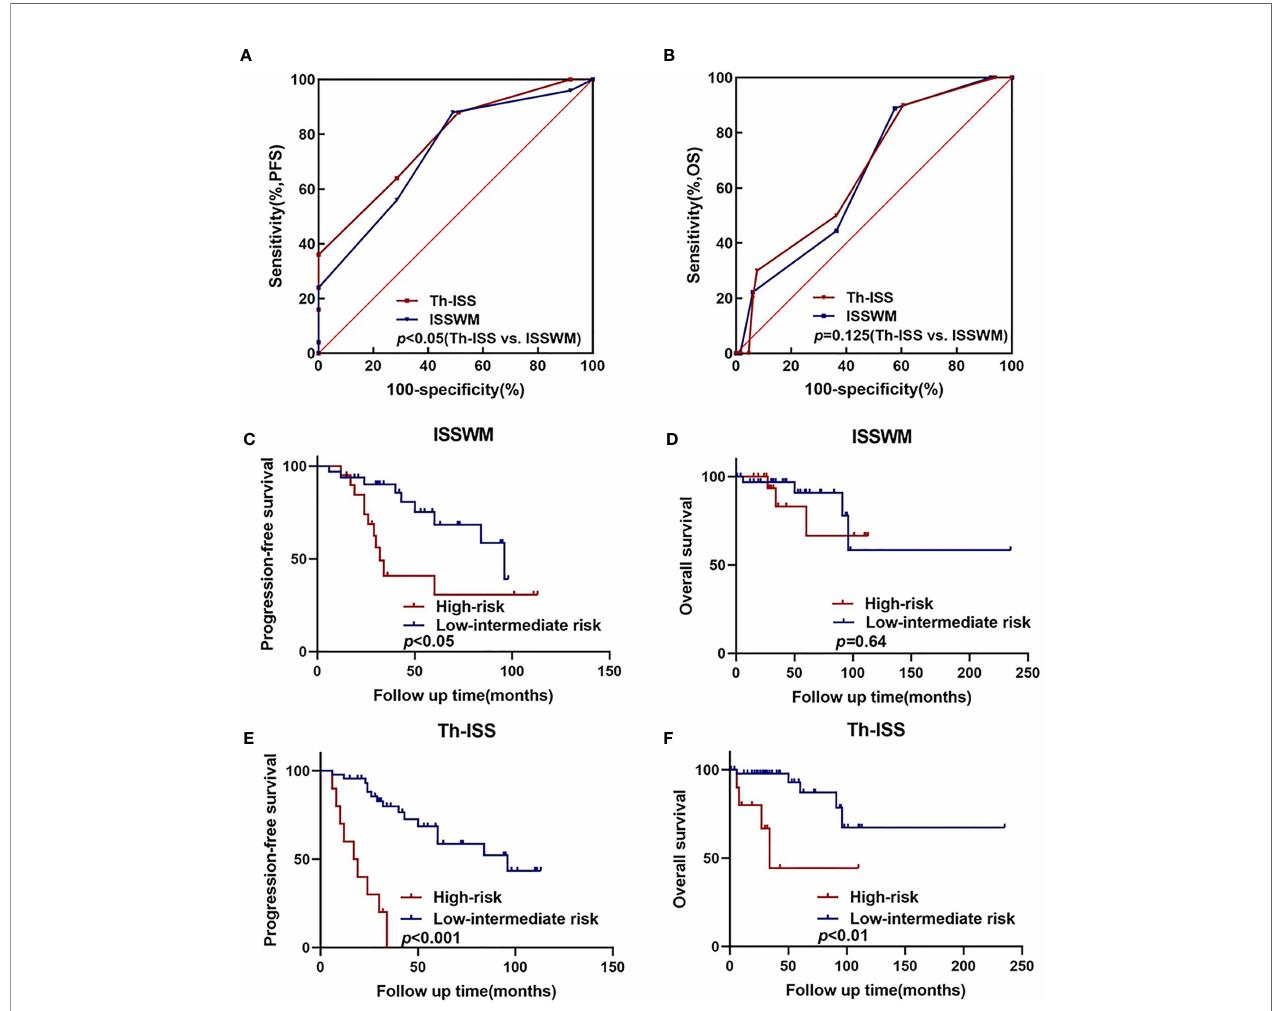
FIGURE 3 | An extended ISSWM score based on thyroid complications. (A, B) The areas under the curve (AUC) comparison between prognostic index including thyroid complications alone, ISSWM, and combination (ISSWM) for PFS and OS prediction. (C, D) Kaplan – Meier curves of PFS and OS for different ISSWM risk grades. (E, F) Kaplan – Meier curves of PFS and OS for different Th-ISS risk